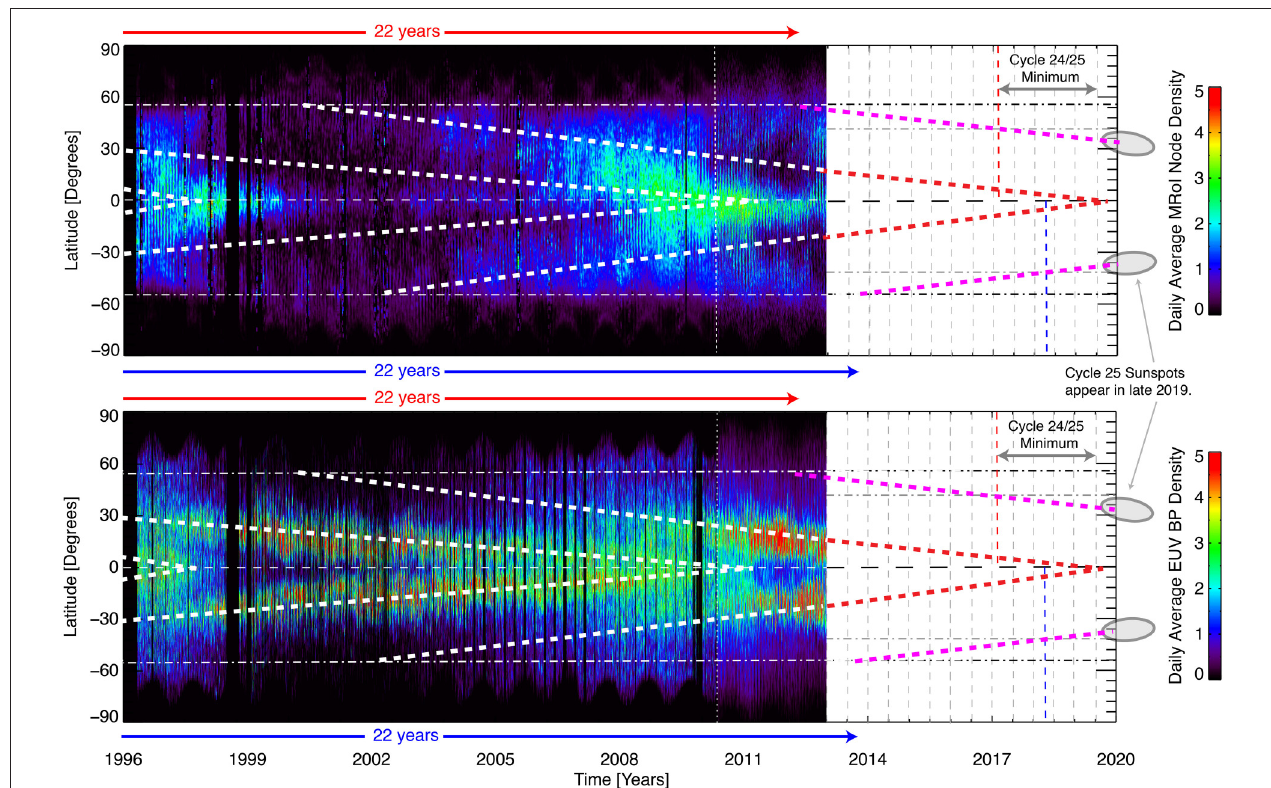
FIGURE 1 | The extrapolation of the inferred magnetic activity bands based on the analysis of McIntosh et al. (2014b) (Figures 6, 17). The white dashed lines are fitted to the latitudinal maxima of the daily hemispheric g-node (Top) and BP (Bottom) density functions that illustrate the complete migratory progress of solar cycle 24. The red-dashed lines are the linear continuation of the solar cycle 24 bands. The projected onset of the solar cycle 25 activity bands appear as pink dashed lines starting at high latitudes 22 years from the start of their cycle 23 counterparts. The faint vertical dashed gray lines in the panels are 6 months